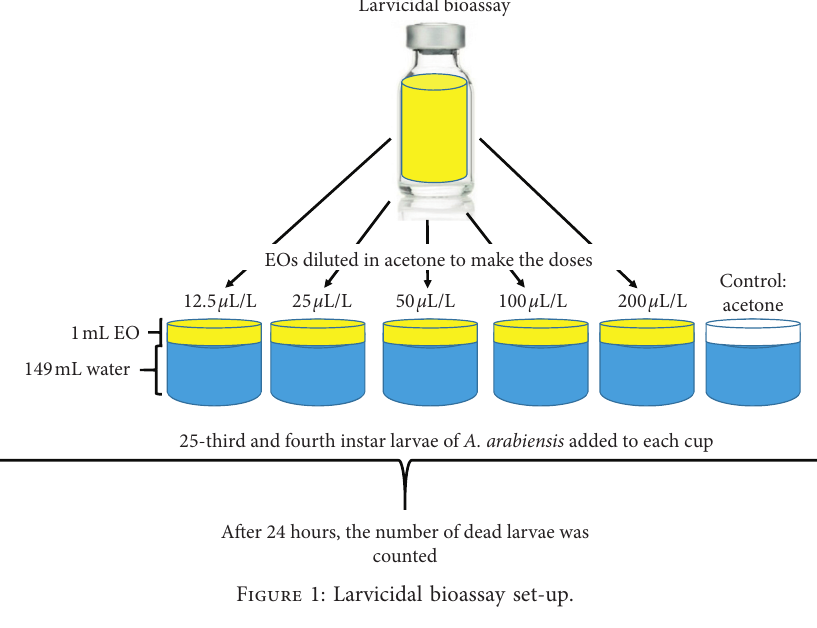
Figure 1: Larvicidal bioassay set-up.